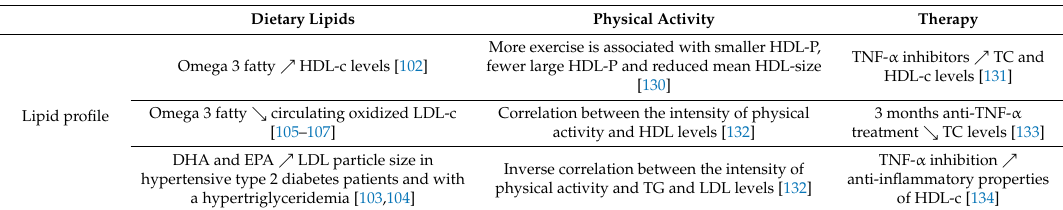
Table 2. Protective e ff ect of nutrition, therapy and physical activity on lipid metabolism disorders and CV